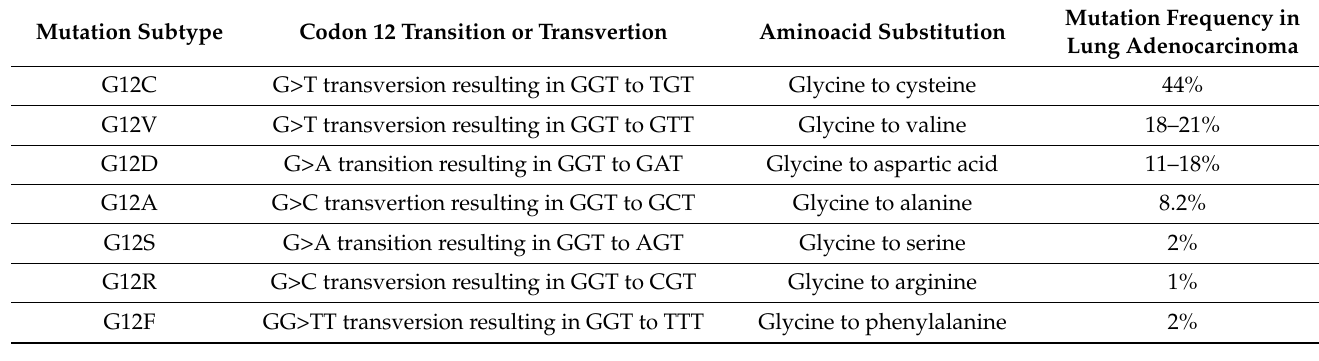
Table 1. KRAS mutation subtypes and their incidence in lung adenocarcinoma.